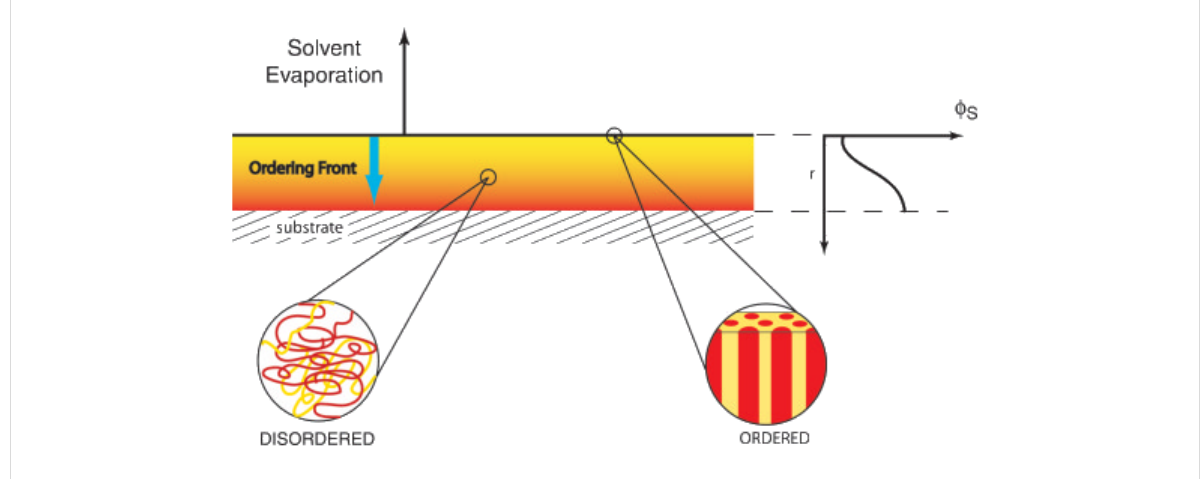
Figure 2: Schematic representation of the solvent evaporation in a thin film made by block copolymer. At the surface, the concentration of the solvent is low and the copolymer undergoes a well-ordered microphase separation. A gradient in the concentration of the solvent (as a function of the film thickness, r ) is established perpendicular to the surface. In the bulk, the concentration of the solvent is high, thus block copolymer chains forming the interior part of the film are disordered. As the solvent evaporates, an ordered front propagates through the film thickness, producing a high vertically ordered cylindrical microdomain orientation. Reprinted with permission from [90], copyright 2004